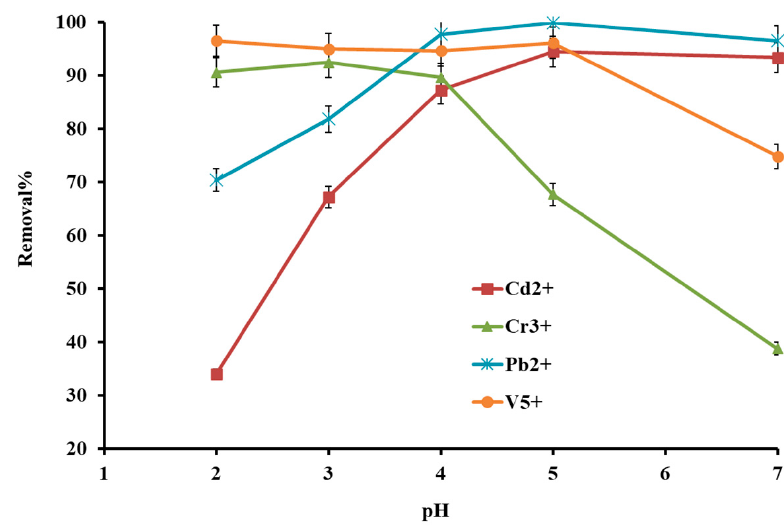
Figure 5. Effect of solution pH on metal ion removal efficiency.